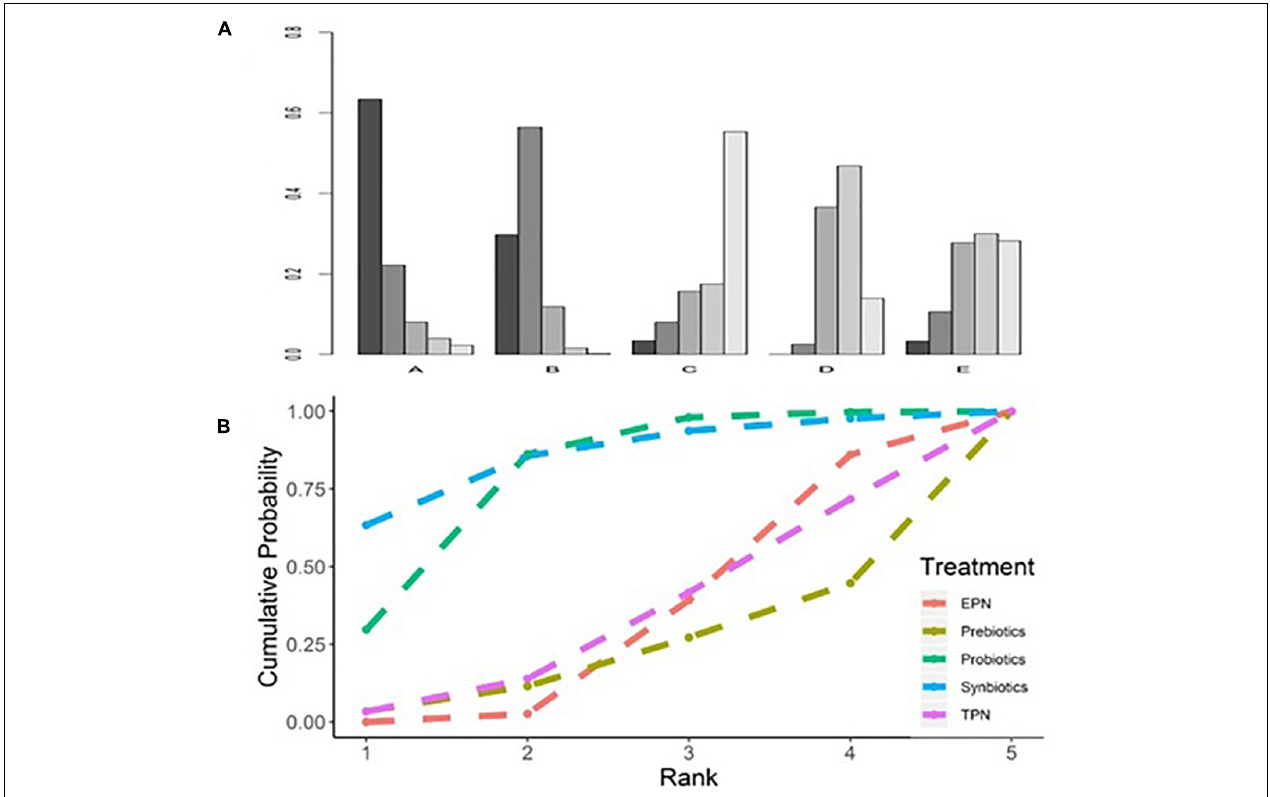
FIGURE 5 | Rankogram and SUCRA ranking curve for ventilator-associated pneumonia. (A) Rankogram for ventilator-associated pneumonia. A = Synbiotics. B = Probiotics. C = Probiotics. D = EPN. E = TPN. (B) SUCRA ranking for ventilator-associated pneumonia. The number on the X -axis represents the rank. As the number goes up, the rating goes down. EPN, enteral nutrition and/or adjuvant peripheral parenteral nutrition. TPN, total parenteral